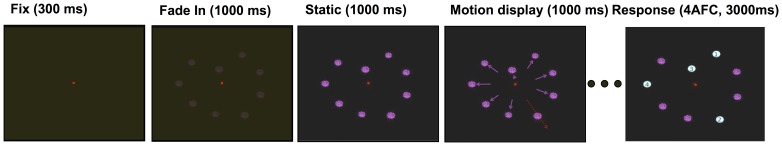
Time course of the VS stimulus.First, the fixation mark appeared on a blank screen and lasted 300 ms. Next, the 9 textured spheres faded in from the background over a 1000 ms period. Then, the spheres remained static for 1000 ms. This was followed by displaying the stimulus motion for 1000 ms, 8 spheres simulating forward observer motion and the other (target) had independent motion, forward or backward with different speeds than that o the observer. Finally, the response period, lasting 3000 ms, displayed the spheres static, four of which were labeled with numbers 1–4, one corresponding to the target. The subject's task was to chose the number corresponding to target.